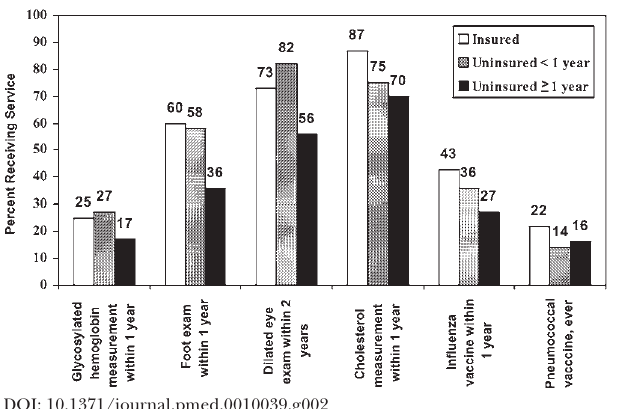
Figure 1. Diabetes Management among Insured and Uninsured Adults, Ages 18–64 The fi gure is based on data from a United States national survey of 105,764 adults in 1997 and 117,364 in 1998 [5]. The proportions have been adjusted to the demographic characteristics of the study cohort, controlling for age, sex, race/ ethnicity, region, employment status, education, and income. (Reprinted, with permission, from [4], courtesy of the